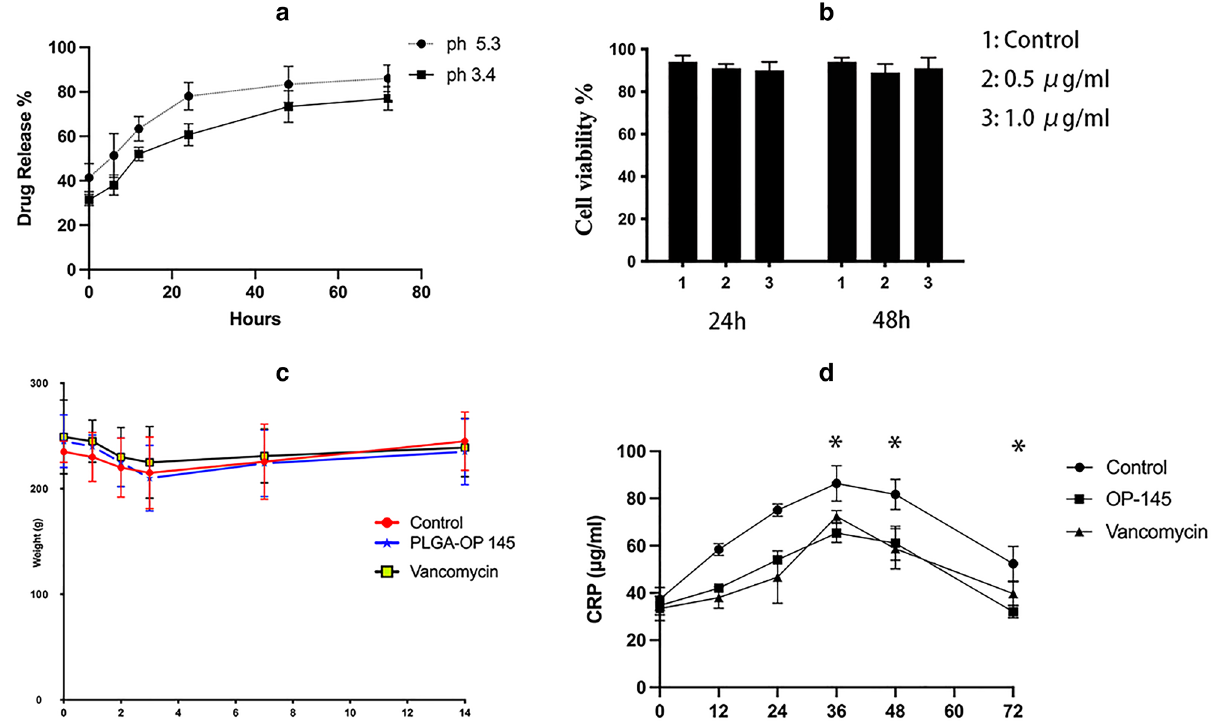
Figure 5. ( a ) The drug release of OP-145 at pH values of 5.3 and 3.4 at 0, 6, 12, 24, 48, and 72 h; ( b ) the cytotoxicity of OP-145 (0.5 and 1 µg/mL) to bone marrow stromal cell; ( c ) the weight of the OP-145, control animals, and vancomycin animals; ( d ) CRP level of OP-145, control animals, and vancomycin animals at 12, 24, 36, 48, and 72